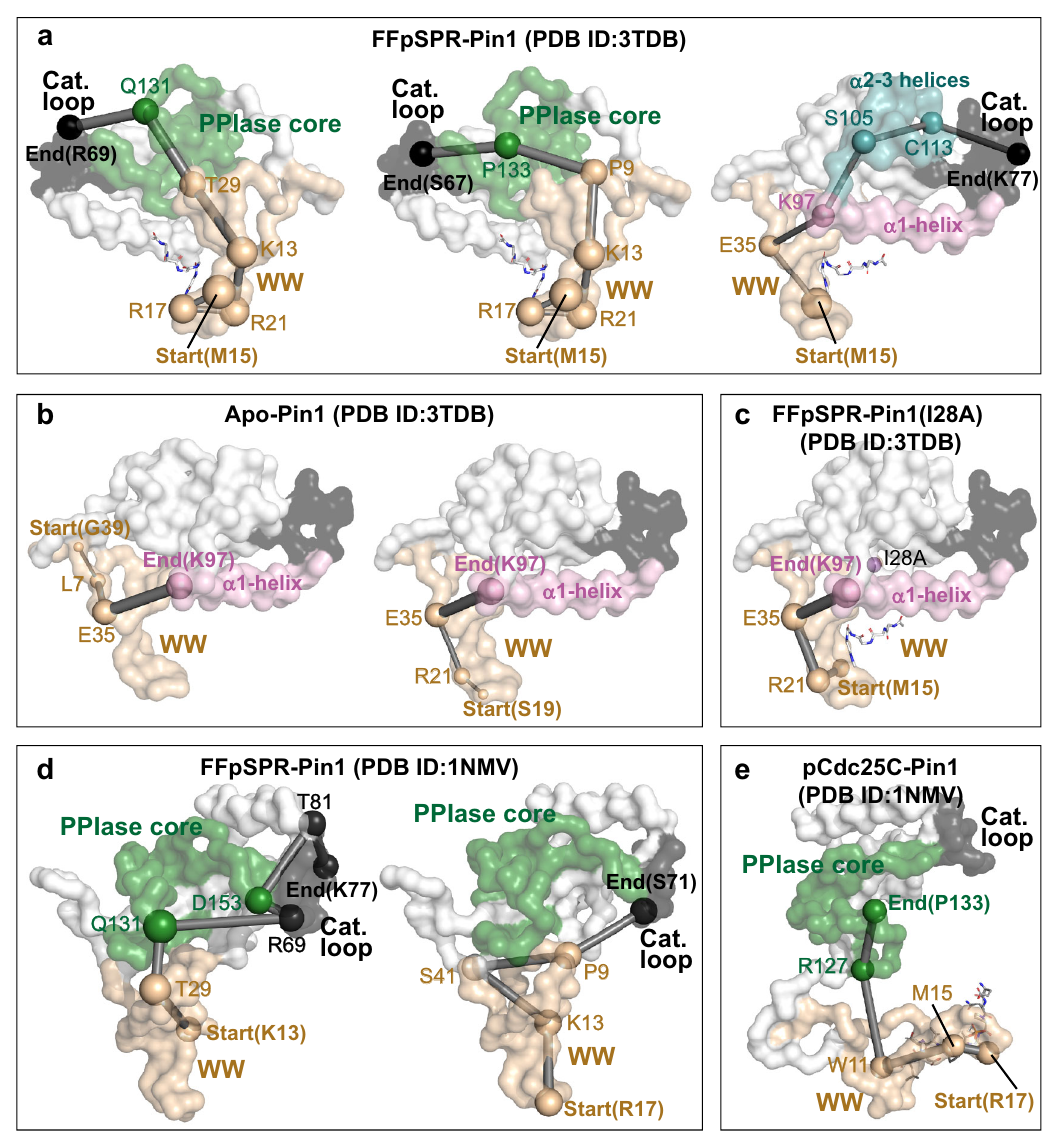
Fig. 3 Pathways mediating inter-domain allosteric communications in Pin1, obtained from the shortest pathway calculation. a Allosteric pathways mediate remote communication from the WW-domain (WW) to the catalytic loop in FFpSPR-Pin1. On the left, the allosteric pathway starts from the WW and continues through Q131 in the PPIase core to R69 in the catalytic loop. In the middle, the allosteric pathway starts from the WW and continues through P133 in the PPIase core to S67 in the catalytic loop. On the right, the allosteric pathway opens communication from the WW and continues through K97 in the α 1-helix and the S105/C113 in the α 2-3 helices to K77 in the catalytic loop. We used the residues in the WW domain as the starting point and the residues in the catalytic loop as the ending points to present the shortest pathways (additional pathways are shown in Supplementary Table 1). In b , the two pathways in apo-Pin1 are illustrated on the left, starting from G39, extending through L7/E35, and ending in K97 in the α 1-helix. The right pathway begins at S19, then extends onward through R21/E35, and ends at K97 in the α 1-helix. c Pathway in I28A FFpSPR-Pin1 starts in M15 and extends through R21/E35, ending at K97 in the α 1-helix. d The two pathways in FFpSPR-Pin1 (PDB ID: 1NMV) are illustrated. On the left, starting from K13, extending through Q131/D153 in the PPIase core and ending in the catalytic loop. On the right, starting from R17, extending through K13/S41/P9 and ending in the catalytic loop. e One pathway that begins at R17, extends through M15/W11, and ends in the PPIase core. The size of a node represents the number of learned edges that directly connect to the node. The thickness of an edge represents the strength of the interaction. The domains/blocks presented here are WW domain (WW), catalytic loop (Cat. loop), α 1-helix ( α 1), α 2-3 helices ( α 2-3), and PPIase